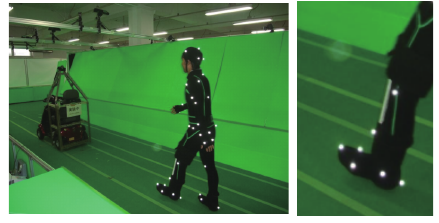
Figure 1: Experimental setup and knee brace